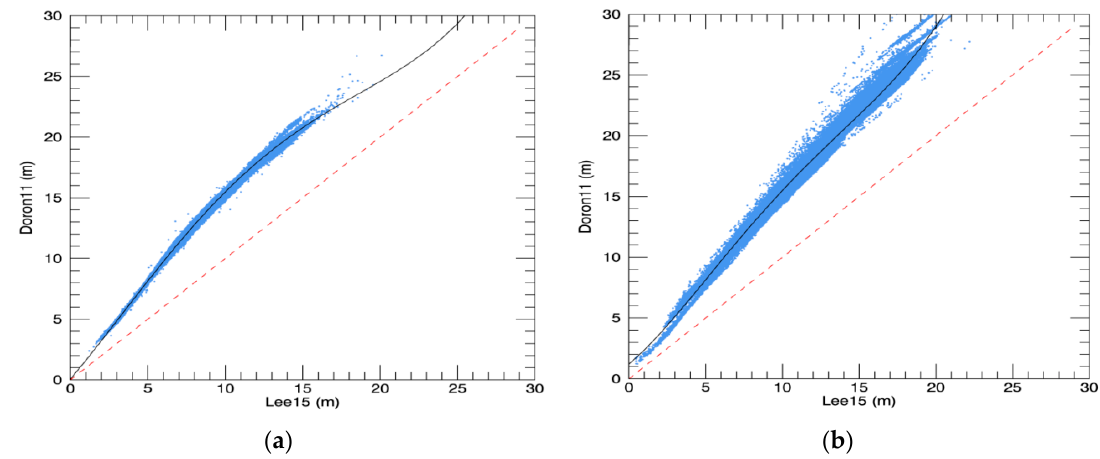
( a ) ( b ) Figure 5. Pixel-based comparison of MERIS-derived SD values using Doron11 algorithm and Lee15 algorithm in Lake Malawi. ( a ) yearly SD values in 2003; ( b ) monthly SD values for January. Table 4. Summary of pixel-based comparison of yearly MERIS-derived SD values using the Doron11 and Lee15 algorithms in Lake Malawi during the study period. The absolute mean difference (AMD) is calculated as averaged |Doron11_SD – Lee15_SD|, and the relative mean difference (RMD) is